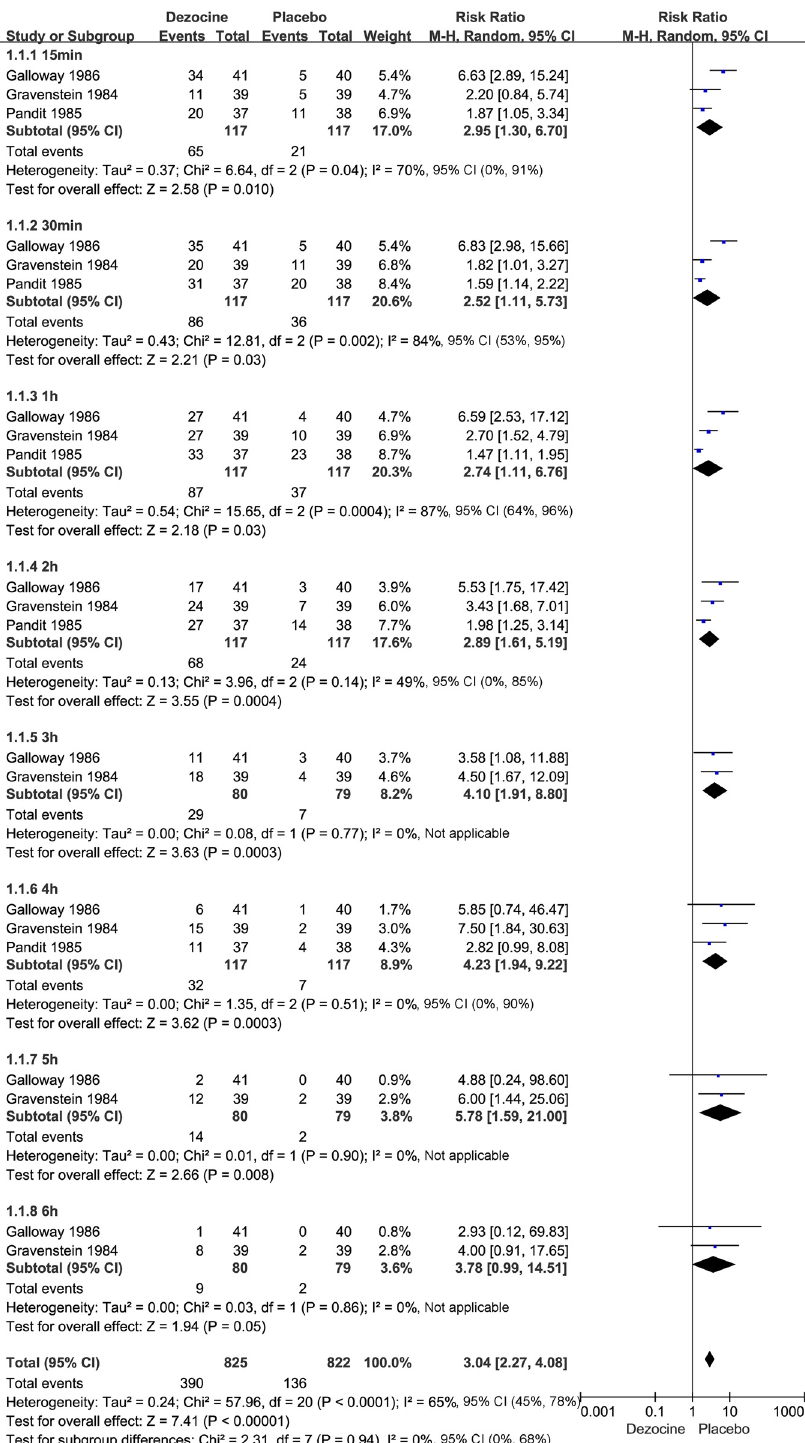
PLOS ONE | DOI:10.1371/journal.pone.0136091 August 19,